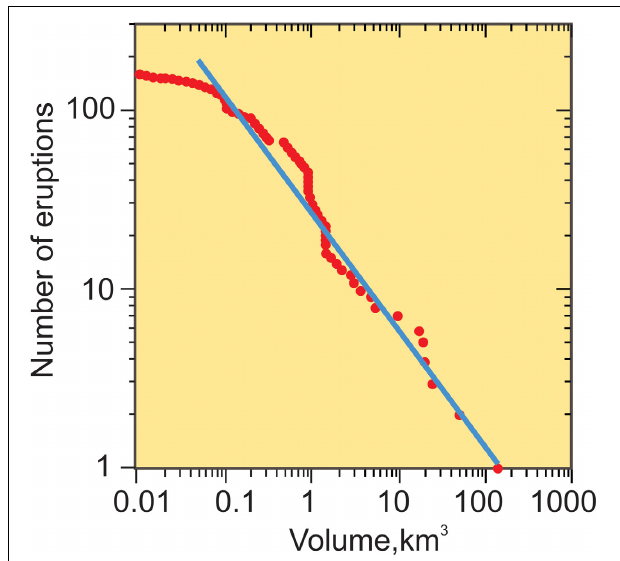
FIGURE 3 | Size distribution of eruption volumes. Here the eruptive volumes are shown in cubic kilometers in relation to the number of eruptions with volumes above a certain size (modified from Pisarenko and Rodkin, 2010). The bi-logarithmic (log-log) plot shows that a straight (blue) line fits much of the distribution rather well, suggesting that the volume distribution of eruptive materials follows approximately a power law. There are various methods for testing how well a power law fits such a distribution in relation to other functions, and also whether more than one straight line (power law) fits the distribution better than a single law (Clauset et al., 2009; Mohajeri and Gudmundsson, 2012; Gudmundsson and Mohajeri,